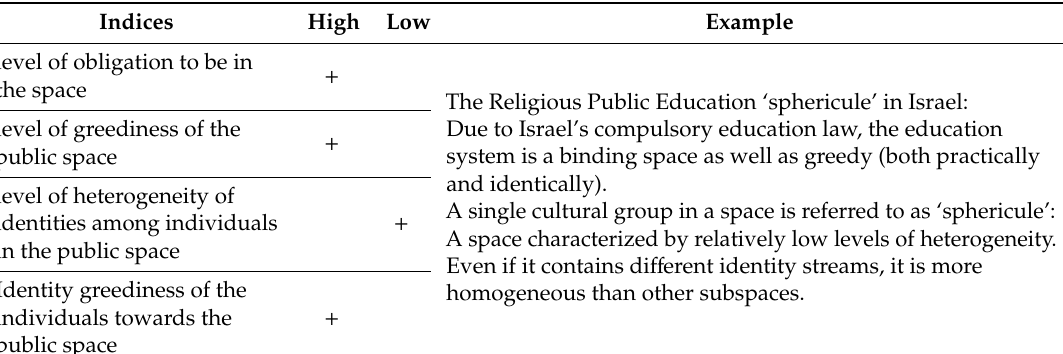
Table A10. Medium potential confrontation.